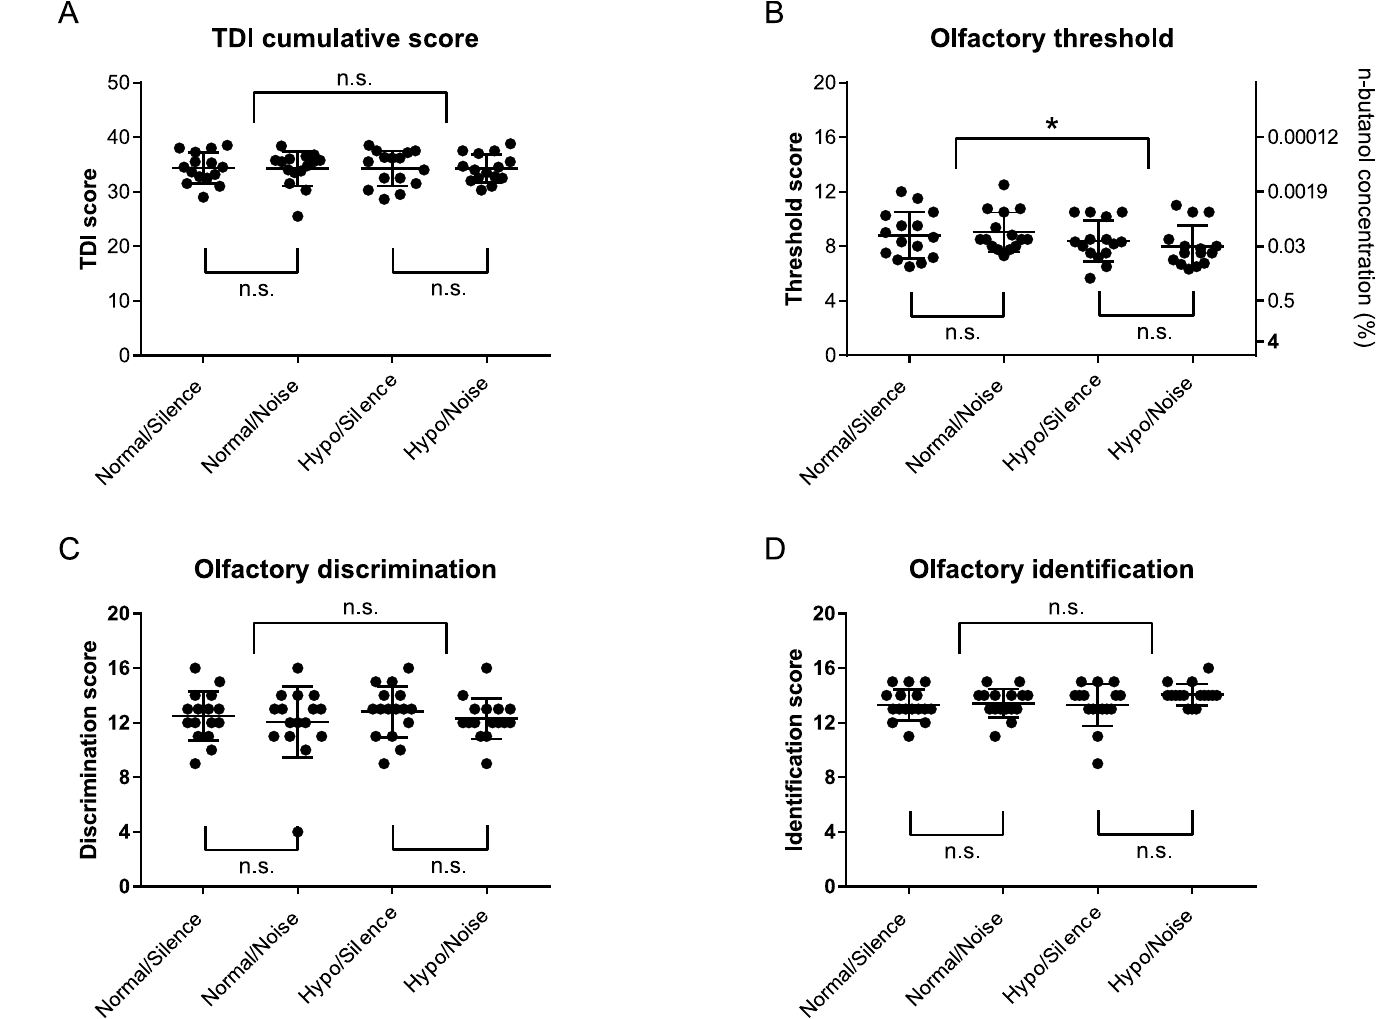
Fig 1. Individual and mean ( ± SD) olfactory function scores based on ‘Sniffin Sticks’. (A) Cumulative TDI, (B) threshold, (C) discrimination, and (D) identification scores. (cid:3) Significant differences at p < 0.05 (ANOVA), n.s.: not significant.